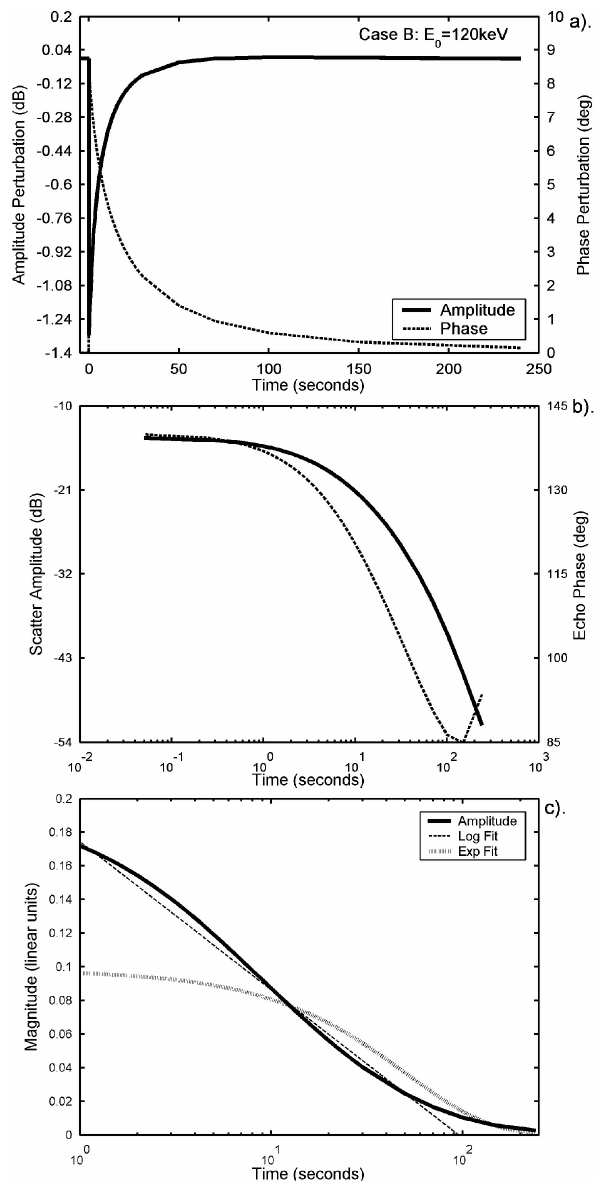
Fig. 5. VLF perturbation in the same form as that shown in Fig. 4, but in this case caused by a WEP burst with an e -folding energy spectra (case